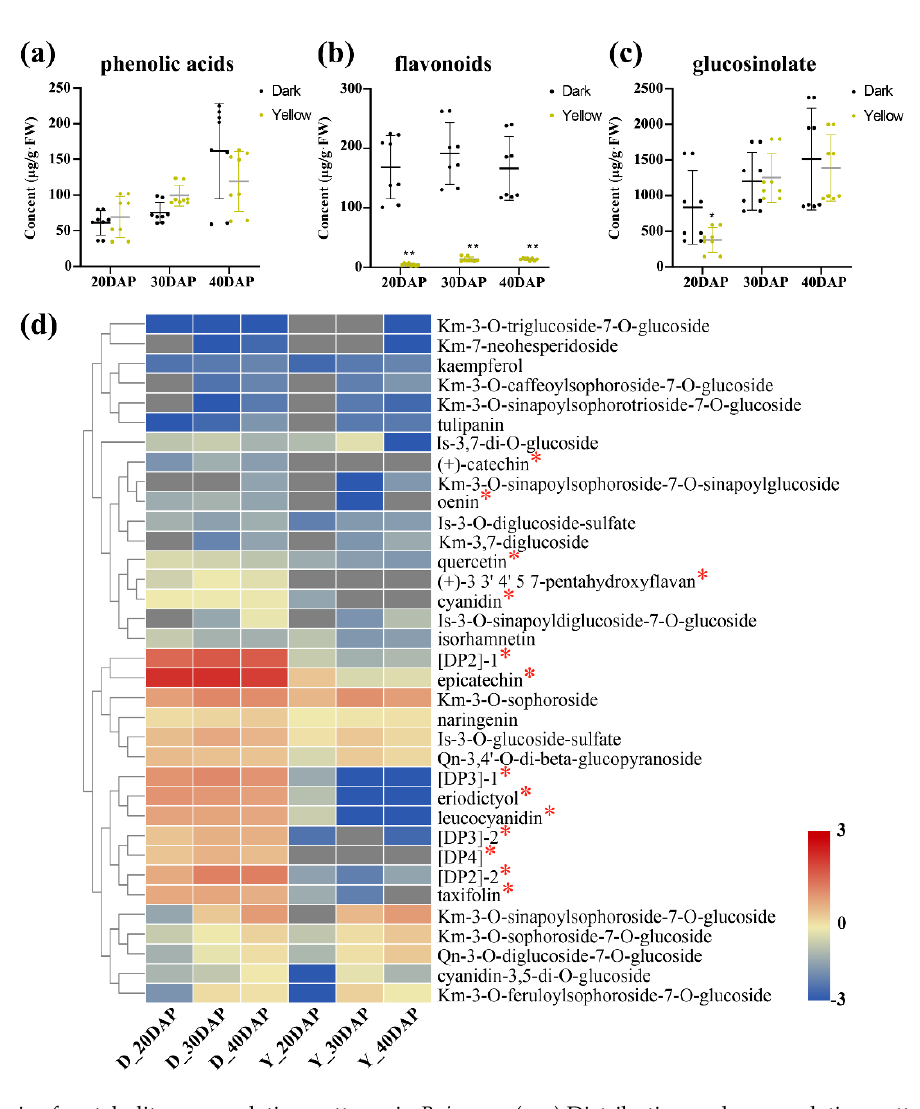
seeded B . juncea during seed development (Figure 3b). These results indicate that flavo- noids might be involved in the determination of seed coat color in B . juncea .